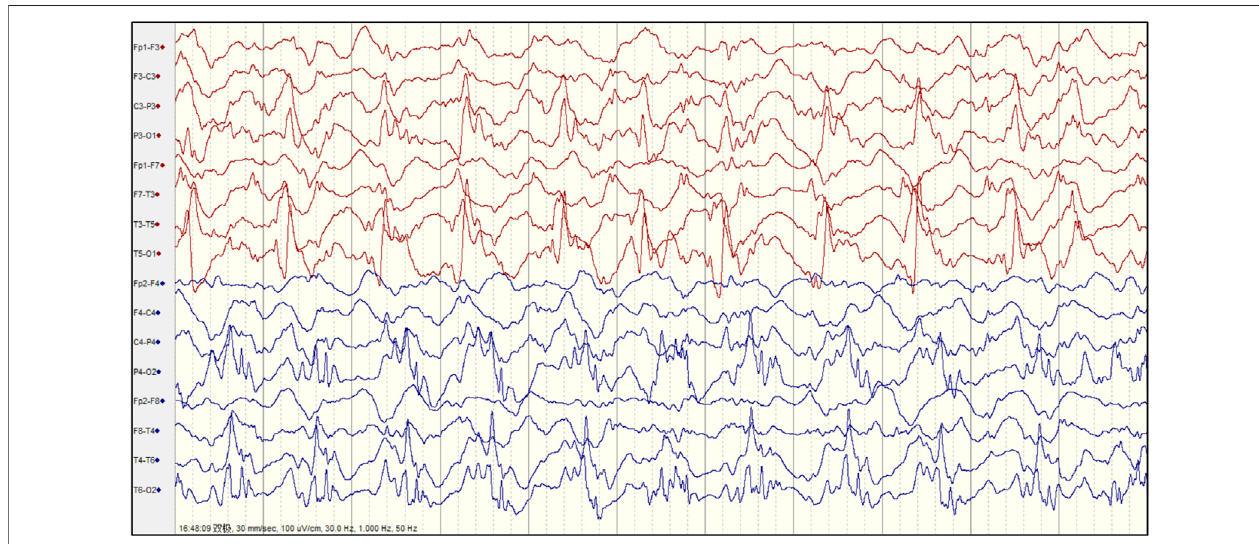
FIGURE 2 | The electroencephalogram (EEG) of patient 4 with Alpers ’ syndrome in our study showed typical rhythmic high amplitude delta waves with superimposed (poly) spikes (RHADS) in the bilateral posterior head region.